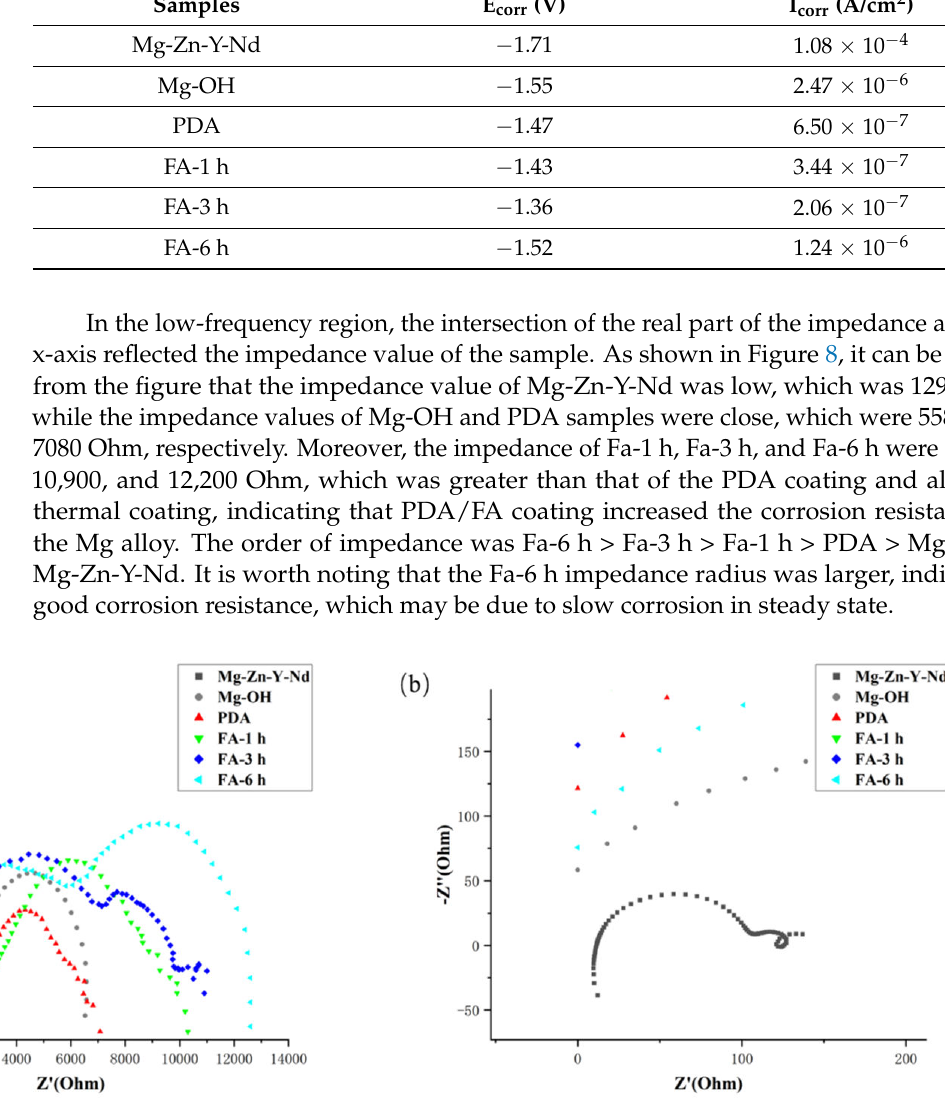
Figure 8. ( a ) EIS Nyquist spectra of the samples in the SBF solution; ( b ) EIS Nyquist spectra of Mg-Zn-Y-Nd in SBF